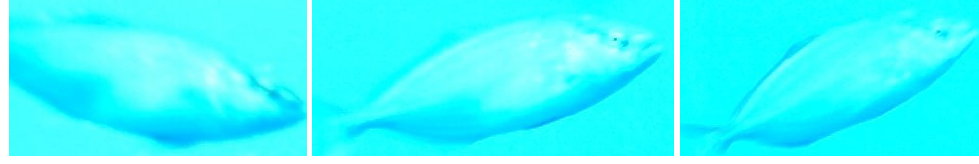
Figure 8. ( a ) An image captured in the Deep Themo deployment with 4 specimens of Seriola dumerili , out of which 3 have been identified during segmentation. ( b ) Segments of the fishes extracted from the